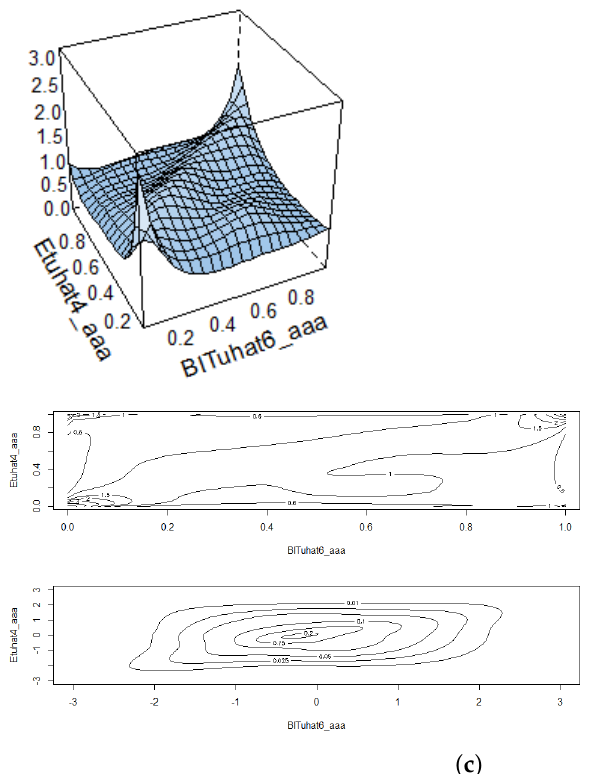
Figure 4. Kernel density estimates of copula fitted to adjusted return series Period 2 COVID-19. ( a ) BITRET and SPRET. ( b ) ETRET and SPRET. ( c ) BITRET and